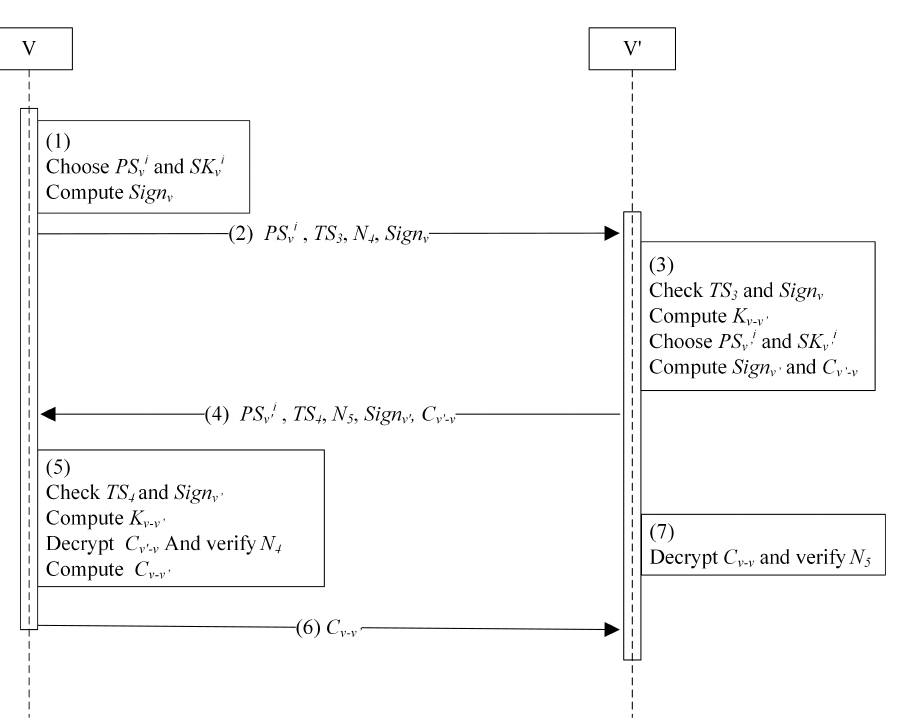
Figure 6. V2V authentication